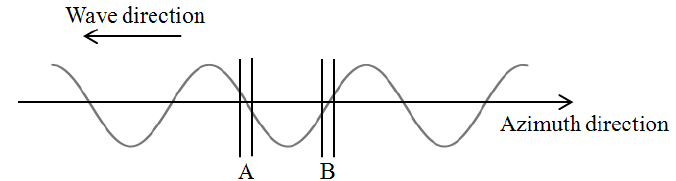
Figure 8. Schematic image of the simulation in the case of regular wave